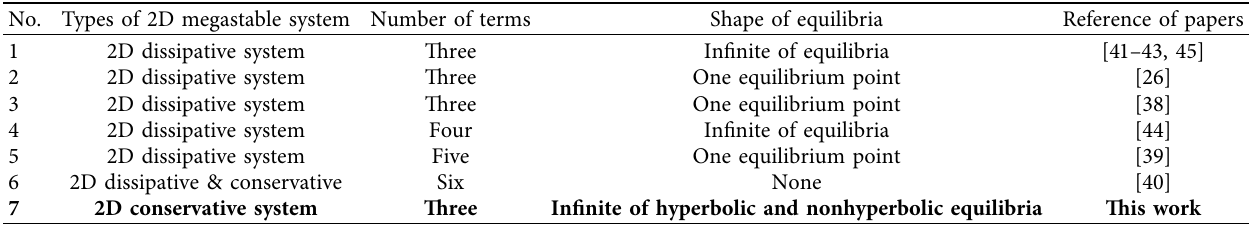
Table 1: Categorization of 2D chaotic megastable systems with number of terms and many equilibria.